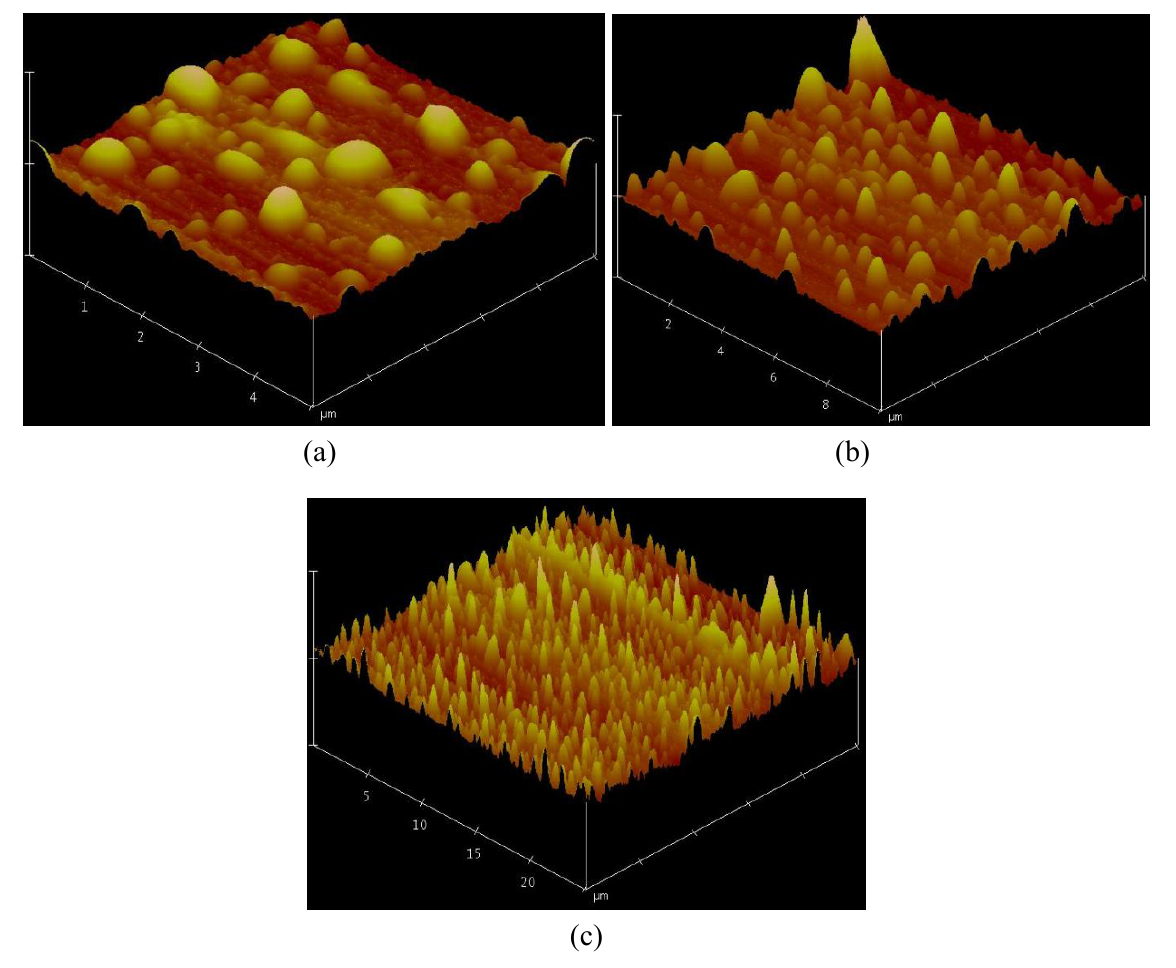
Figure 5. 3D AFM images of the aluminum surface covered by PATP films at